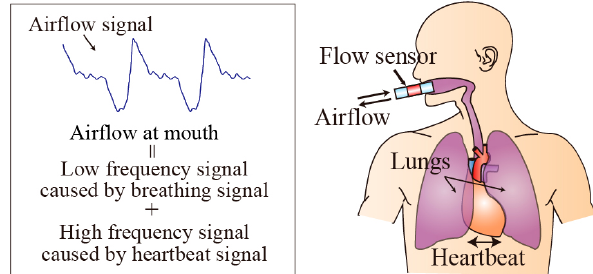
Figure 1. Airflow signal containing both respiration and heartbeat